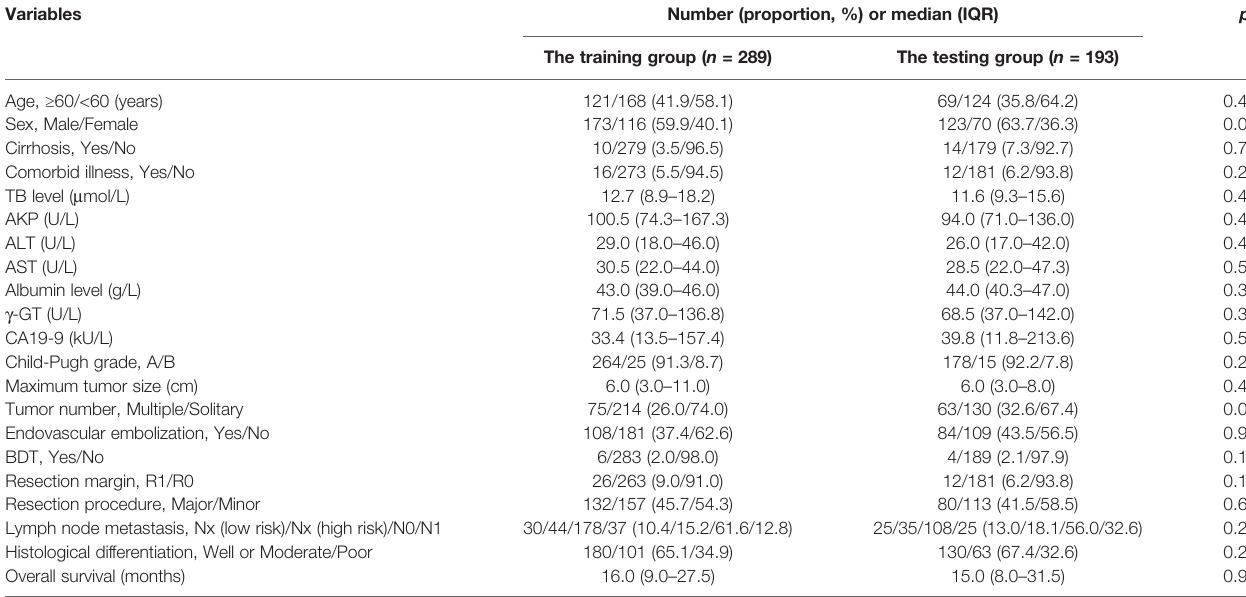
TABLE 1 | Clinical characteristics of the study population.